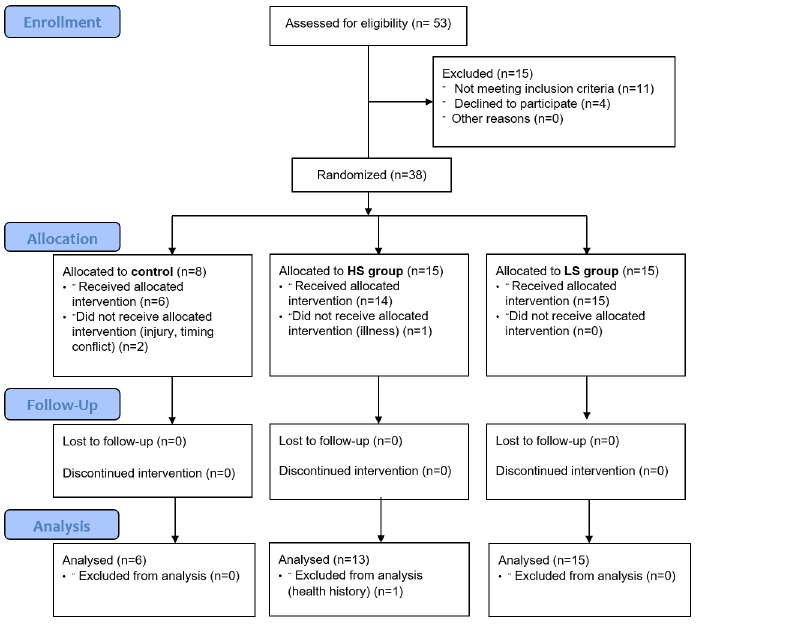
Fig 1. Group assignment. HS = high salience, LS = low salience, C =